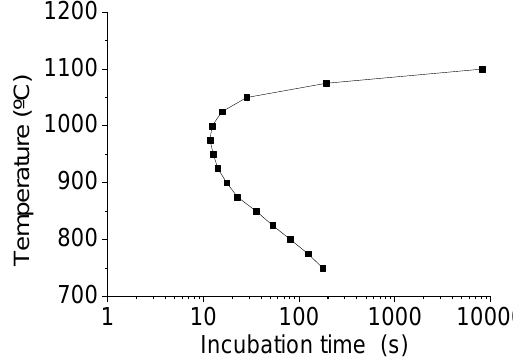
Figure 2. Incubation time vs. temperature (curve P s ) for VCN precipitates.